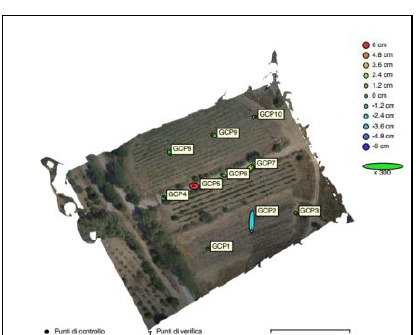
Figure 11. Dense Point Cloud - 80